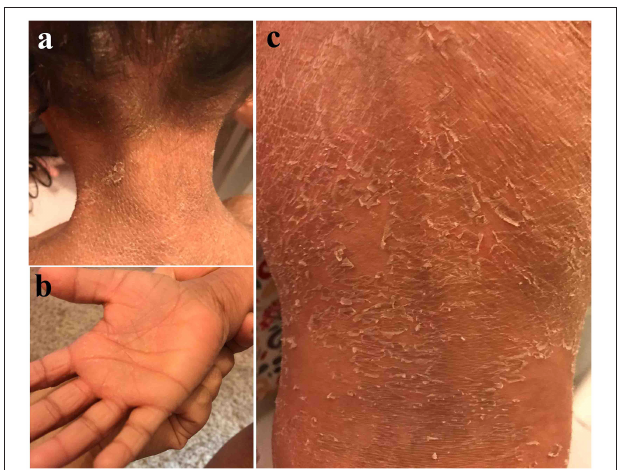
FIGURE 1 | Clinical presentation of patient II-1 in family A. Note the rough and dry skin with over the scalp and neck (a) palmoplantar keratoderma and exfoliation, fissuring on the palms (b) . The upper back area is more prominent with large thick and brownish scales (c)